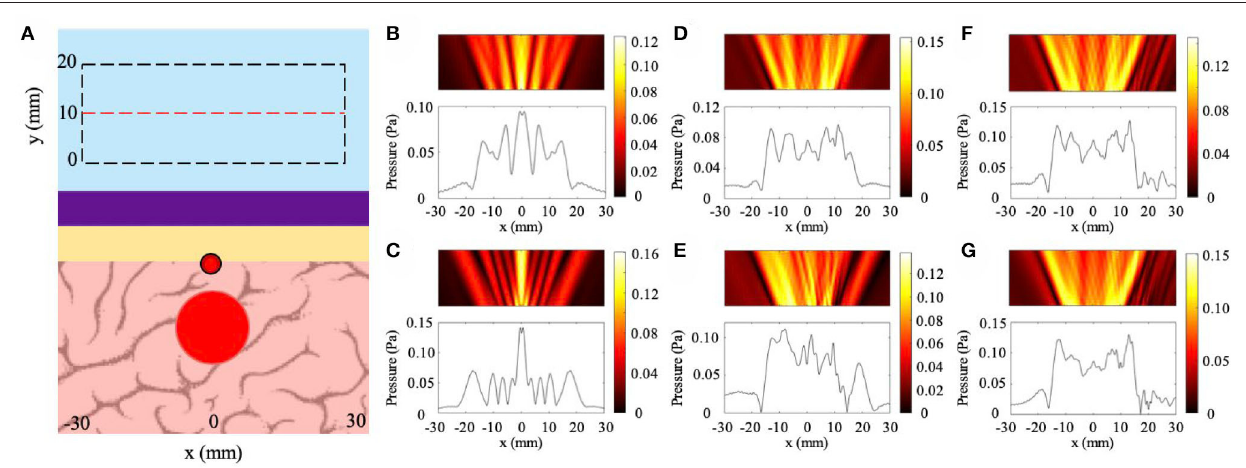
FIGURE 7 | Effects of blood vessel induced indentation on ultrasound imaging with NHCMM. (A) Illustration of the NHCMM-skull bilayer with a blood vessel imprinting on the interior side of the skull. Reflected pressure fields are taken in the black dashed rectangles with the pressure amplitude recorded on the red dashed line. (B) Scattered pressure field from imaging through a skull having a small blood vessel vertically aligned with the tumor and compensated by NHCMM. (C) Scattered pressure field from imaging through a skull having a larger blood vessel vertically aligned with the tumor and compensated by NHCMM. (D) Scattered pressure field from imaging through a skull having a small blood shifted 10mm to the right from its location in (B) compensated by NHCMM. (E) Scattered pressure field from imaging through a skull having a medium blood vessel shifted 10mm to the right from its location in (C) compensated by NHCMM. (F) Scattered pressure field from imaging through a skull having a small blood vessel shifted 20mm to the right from its location in (B) compensated by NHCMM. (G) Scattered pressure field from imaging through a skull having a medium blood vessel shifted 20mm to the right from its location in (C) compensated by NHCMM. The colorbars represent pressure amplitudes in